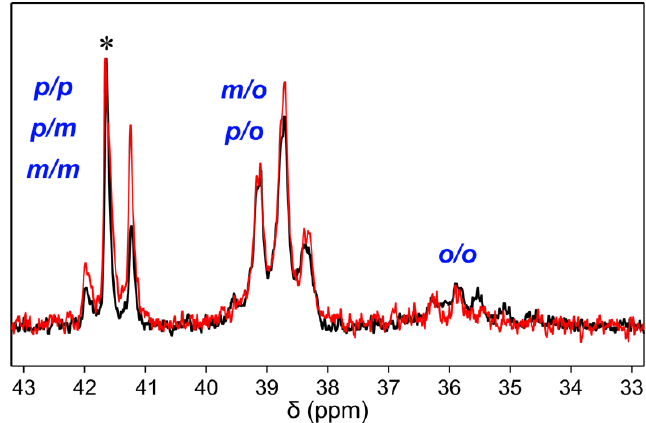
Figure 3. Comparison of the signals of the methylene unit in 13 C NMR spectra for PPM synthesized with SnCl 4 (black) and with [W 2 Br 4 (CO) 7 ] (red). Based on the literature, the three peak groups are assigned to the respective substitution pattern of the two adjacent phenylene rings [1]. The spectra are normalized to the intensity of the peak marked with an asterisk.